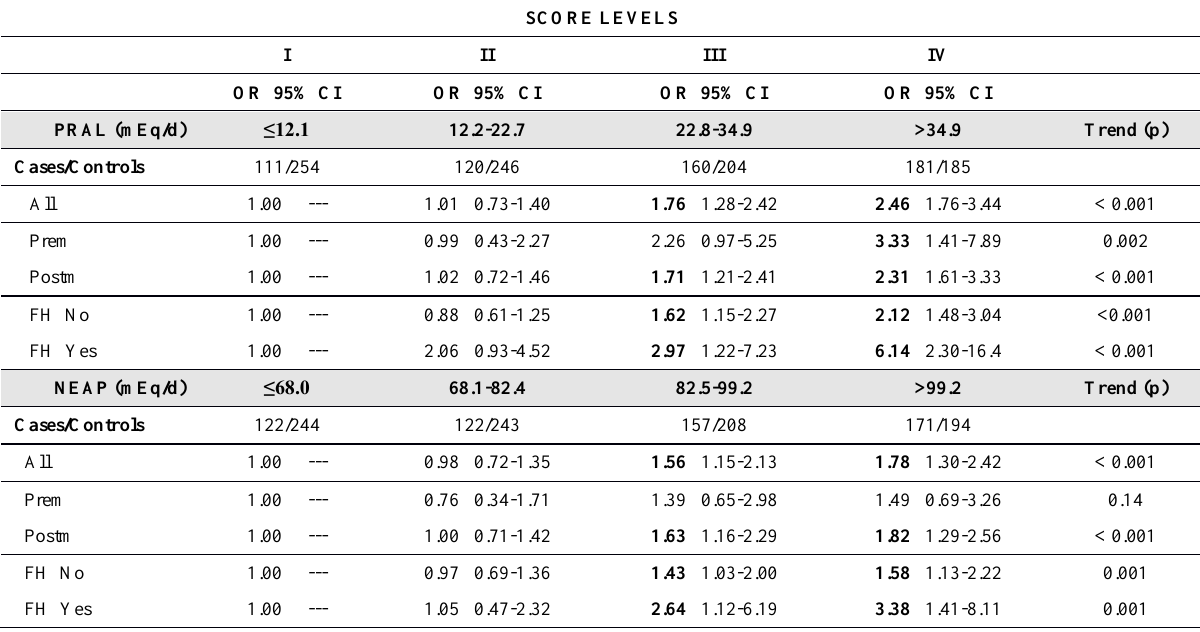
Table 4. Adjusted Odds Ratios (ORs) of BC for acid load scores (PRAL and NEAP), with global estimations and stratified analyses by menopausal status and family history of BC SCORE